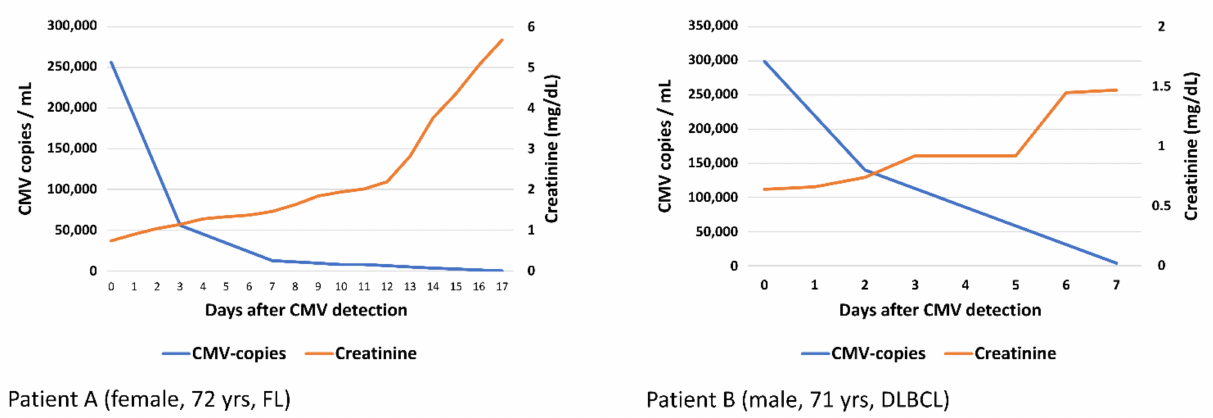
Figure 3. Laboratory values (CMV-DNA, measured by PCR, and creatinine). Laboratory values of CMV copies and creatinine of patient ( A ) and patient ( B ) are displayed. Both patients developed acute kidney failure, most likely as an adverse effect from